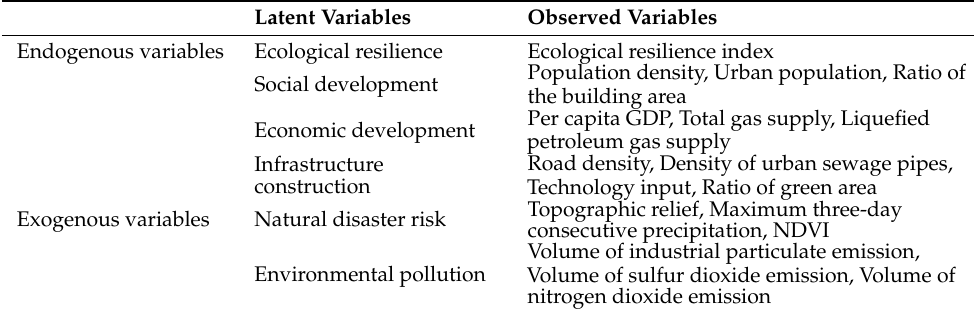
Table 1. Selected variable for identifying key driving factors of ecological